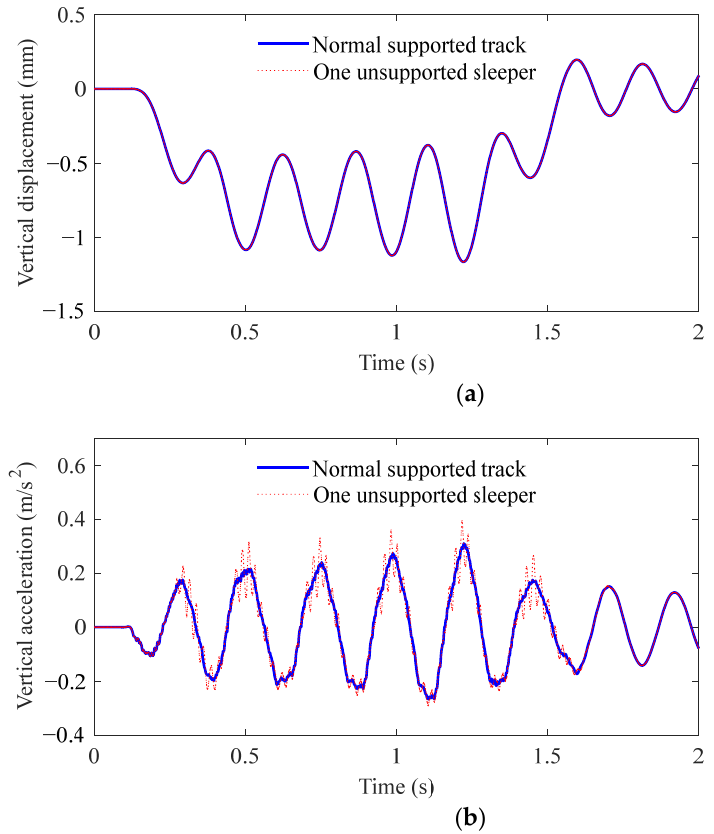
Figure 12. Dynamic responses under the unilateral unsupported sleepers at point B: ( a ) midspan displacement of the bridge and ( b ) midspan acceleration of the bridge.